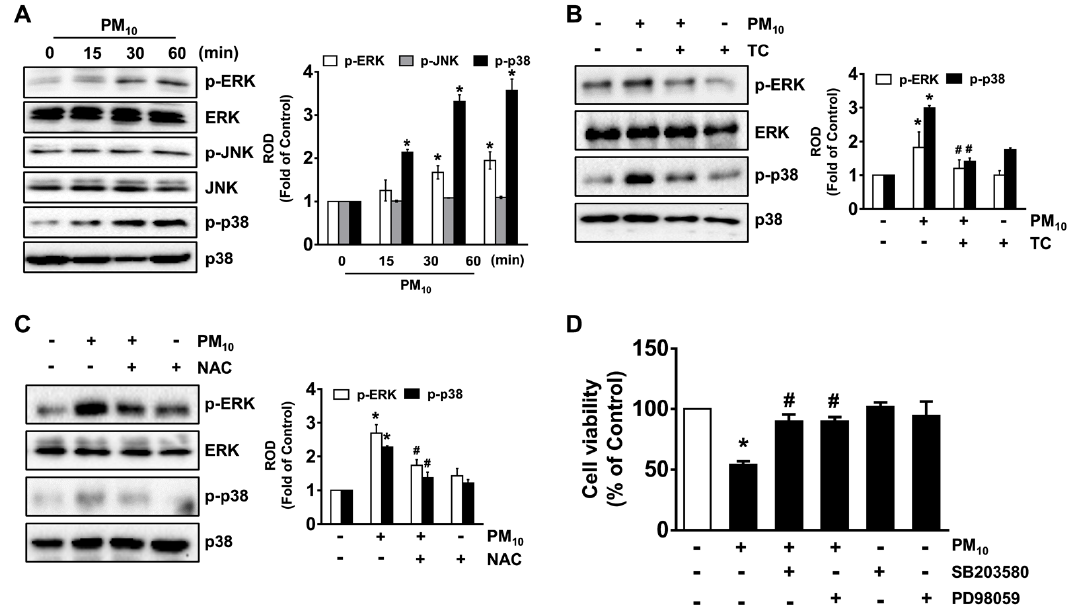
Figure 3. Tart cherry inhibits the activation of the extracellular signal-regulated kinase (ERK) and p38 mitogen-activated protein kinase (MAPK) pathways triggered by PM 10 . ( A ) Time-dependent response of PM 10 (100 µ g/mL) on the activation of mitogen-activated protein kinase (MAPK) in HaCaT cells determined by Western blot. ( B ) The effect of tart cherry (TC, 200 µ g/mL) on the phosphorylation of ERK and p38 MAPK is shown. ( C ) Cells pre-treated with NAC prior to exposure to PM 10 for 30 min. ( D ) Cells pretreated with SB203580 (10 µ M) and PD98059 (10 µ M) as inhibitors for p38 MAPK and ERK were incubated with PM 10 for 24 h. Cell viability was determined. ( A – D ) Data are represented as the means ± S.E. n = 3. * p ≤ 0.01 vs. control. # p ≤ 0.05 vs. PM 10 alone. ROD, relative optical density.